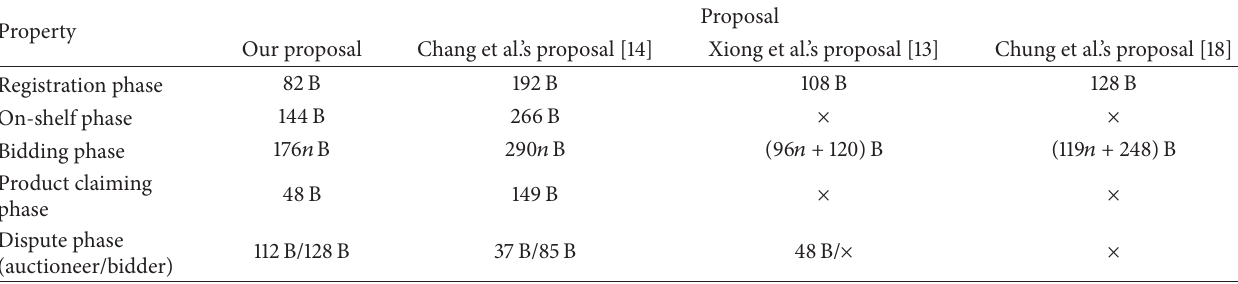
Table 3: Comparison in traffic of the three schemes (B: bytes).